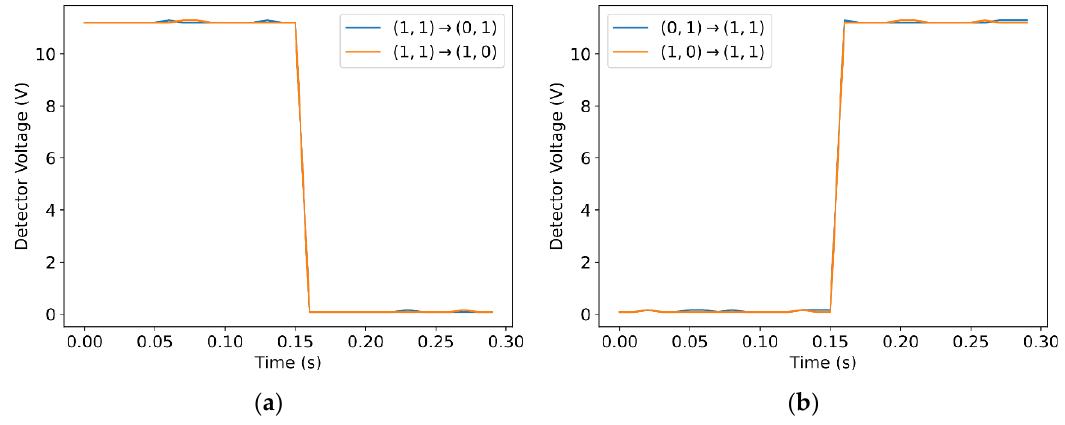
between several transitions of UFL states and are 𝜆𝜆 1 , 1